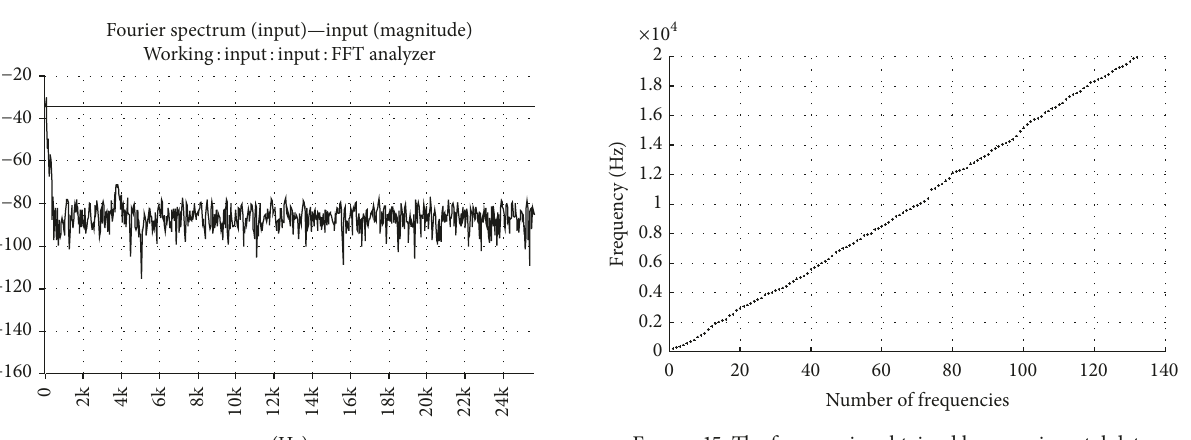
Figure 15: The frequencies obtained by experimental data.